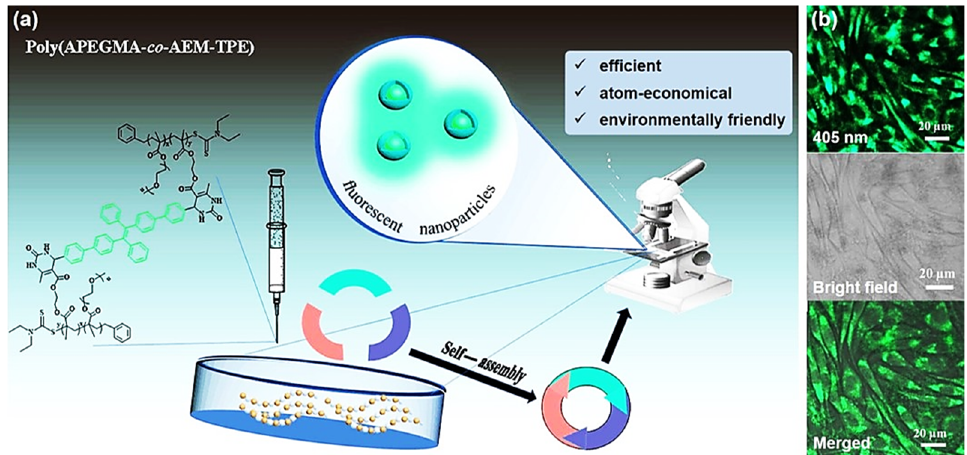
Figure 8. Cross-linked-aggregation-induced emission (AIE) probe for cell imaging via the Biginelli reaction. ( a ) The molecular structure and properties of the AIE probe poly(PEGMA-co-AEMA-TPE); ( b ) confocal images of L929 cells incubated with poly(PEGMA-co-AEMA-TPE) (30 µg/mL) for 3 h ( top : the fluorescent image of L929 cells under a 405 nm laser; middle : the bright field image; bottom : the merged image). Reprinted with permission from ref. [57]. Copyright © 2018 Elsevier Inc. All rights reserved.